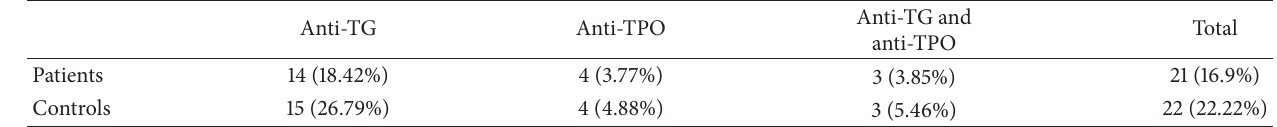
Table 1: Frequency of thyroid autoantibodies in the study group.